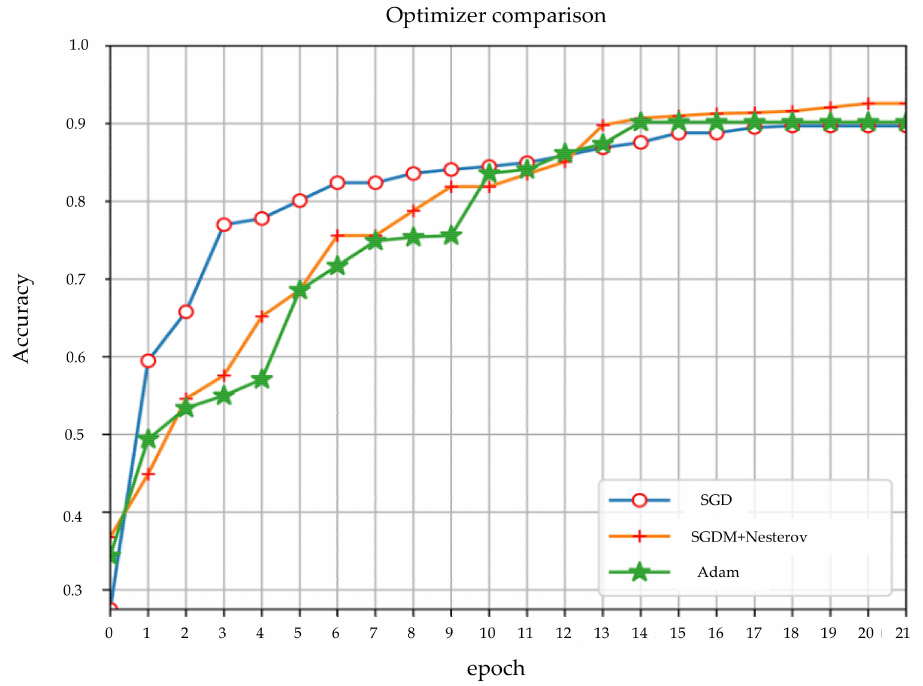
Figure 4. Comparison of the accuracy of the optimizers Adam, SGD, and SGDM + Nesterov.